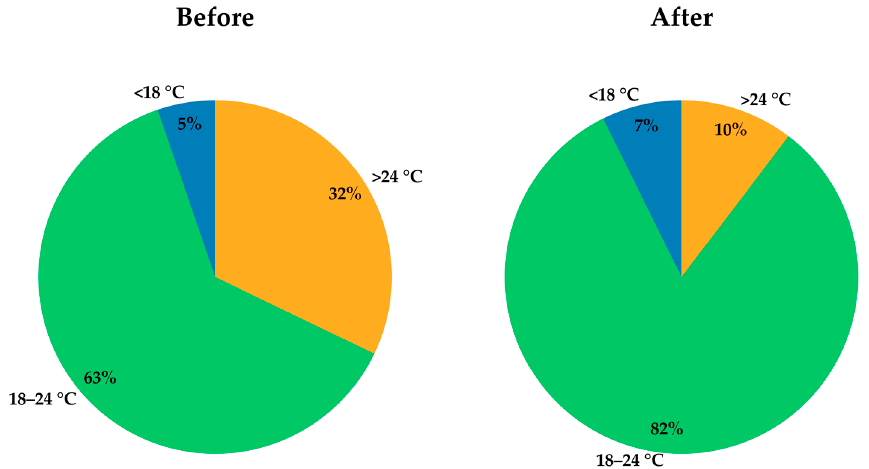
Figure 7. Room temperature distribution of the Welsh pilot site while occupants are present in the room before and after renovation.